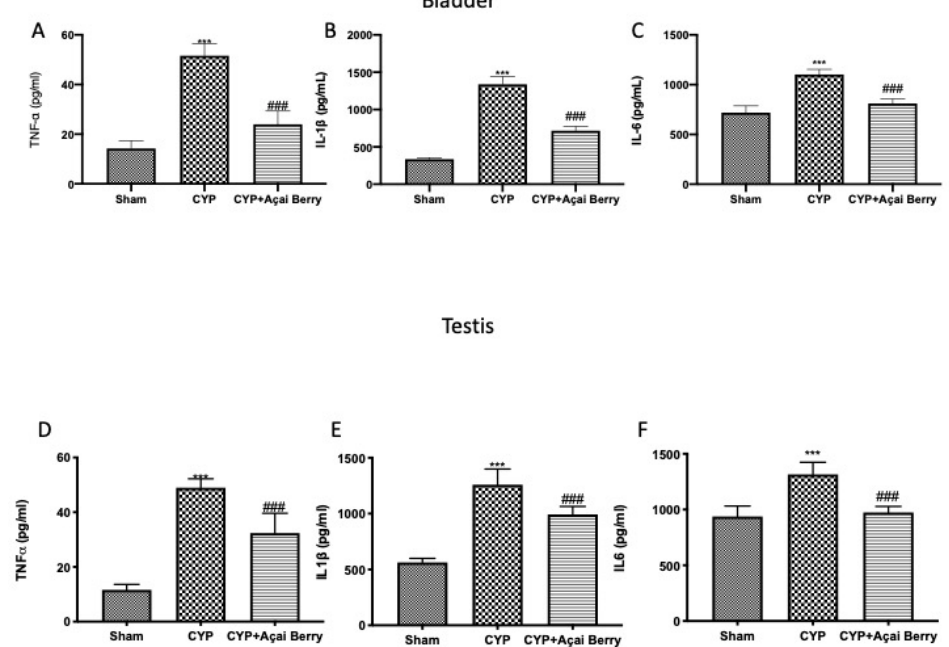
Figure 4. Effect of açai berry on cytokine storm. ELISA quantification of ( A ) TNF- α , ( B ) IL-1 β , and ( C ) IL-6 levels in bladder and ( D ) TNF- α , ( E ) IL-1 β , and ( F ) IL-6 levels in testes. *** p < 0.001 vs. sham; ### p < 0.001 vs. CYP.